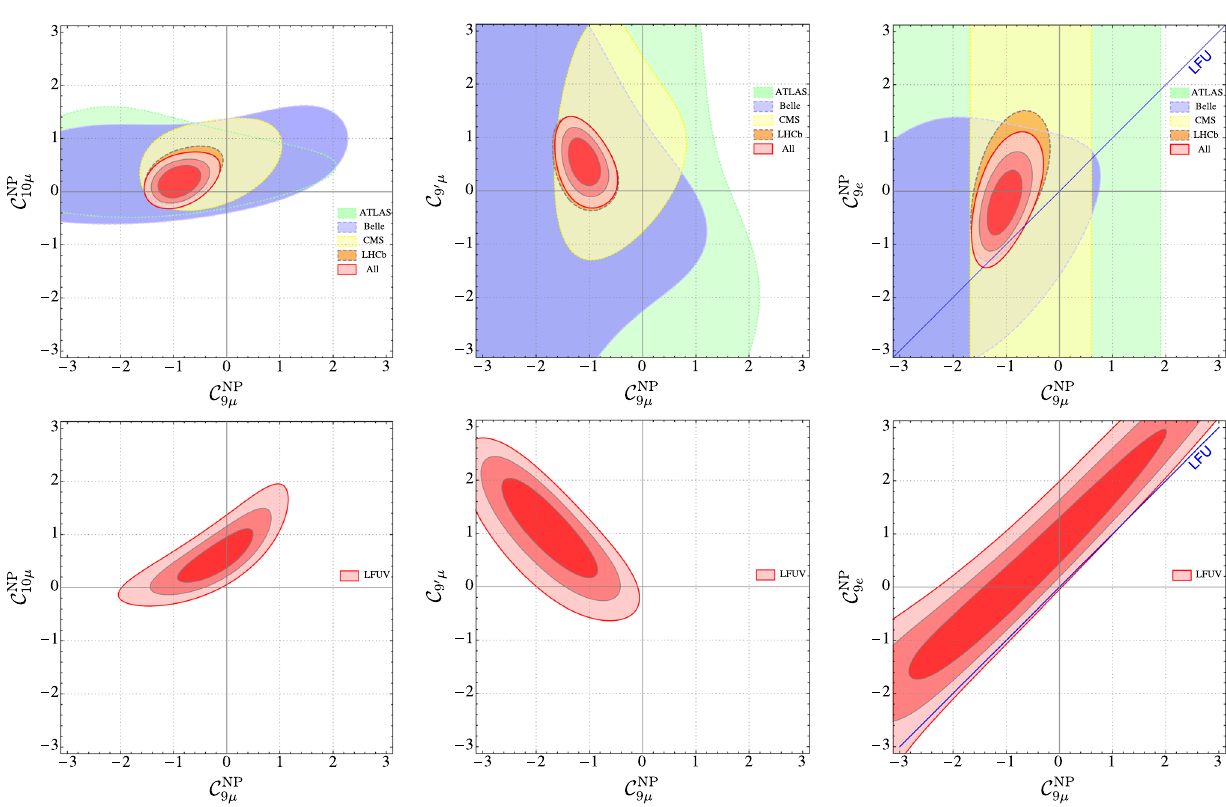
, C NP ) , ( C NP , C ) and ( C NP , C NP ) planes for the corresponding 2D hypotheses, using all 9 (cid:4) μ 9 μ 10 μ 9 μ 9 μ 9 e